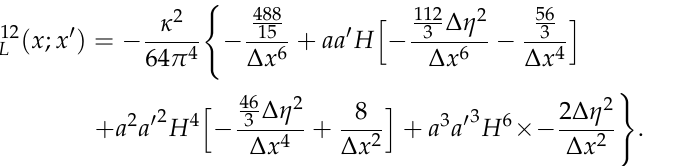
Table 5. Each tabulated term must be multiplied by κ 2